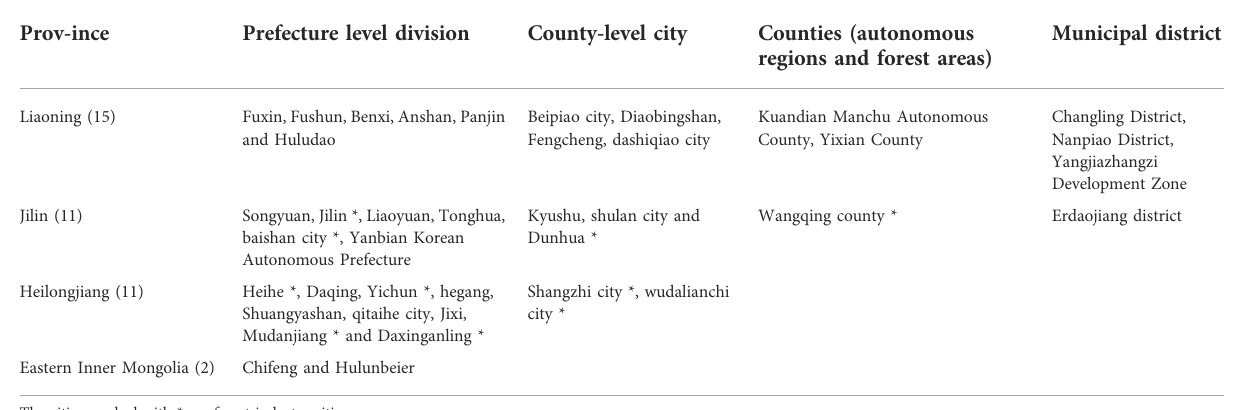
TABLE 1 List of RBCs in northeast